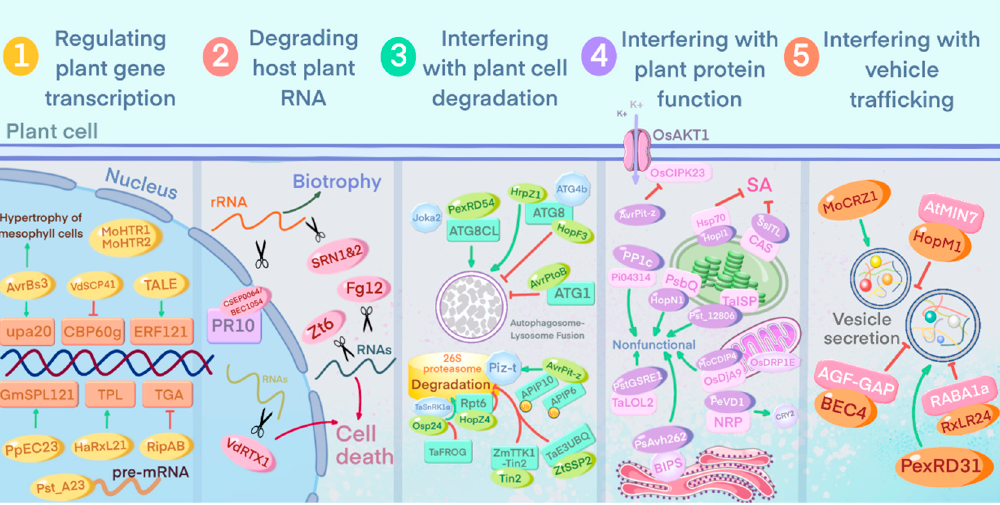
Figure 4. Effectors interfere with host plant cell physiological activities. AvrBs3, VdSCP41,